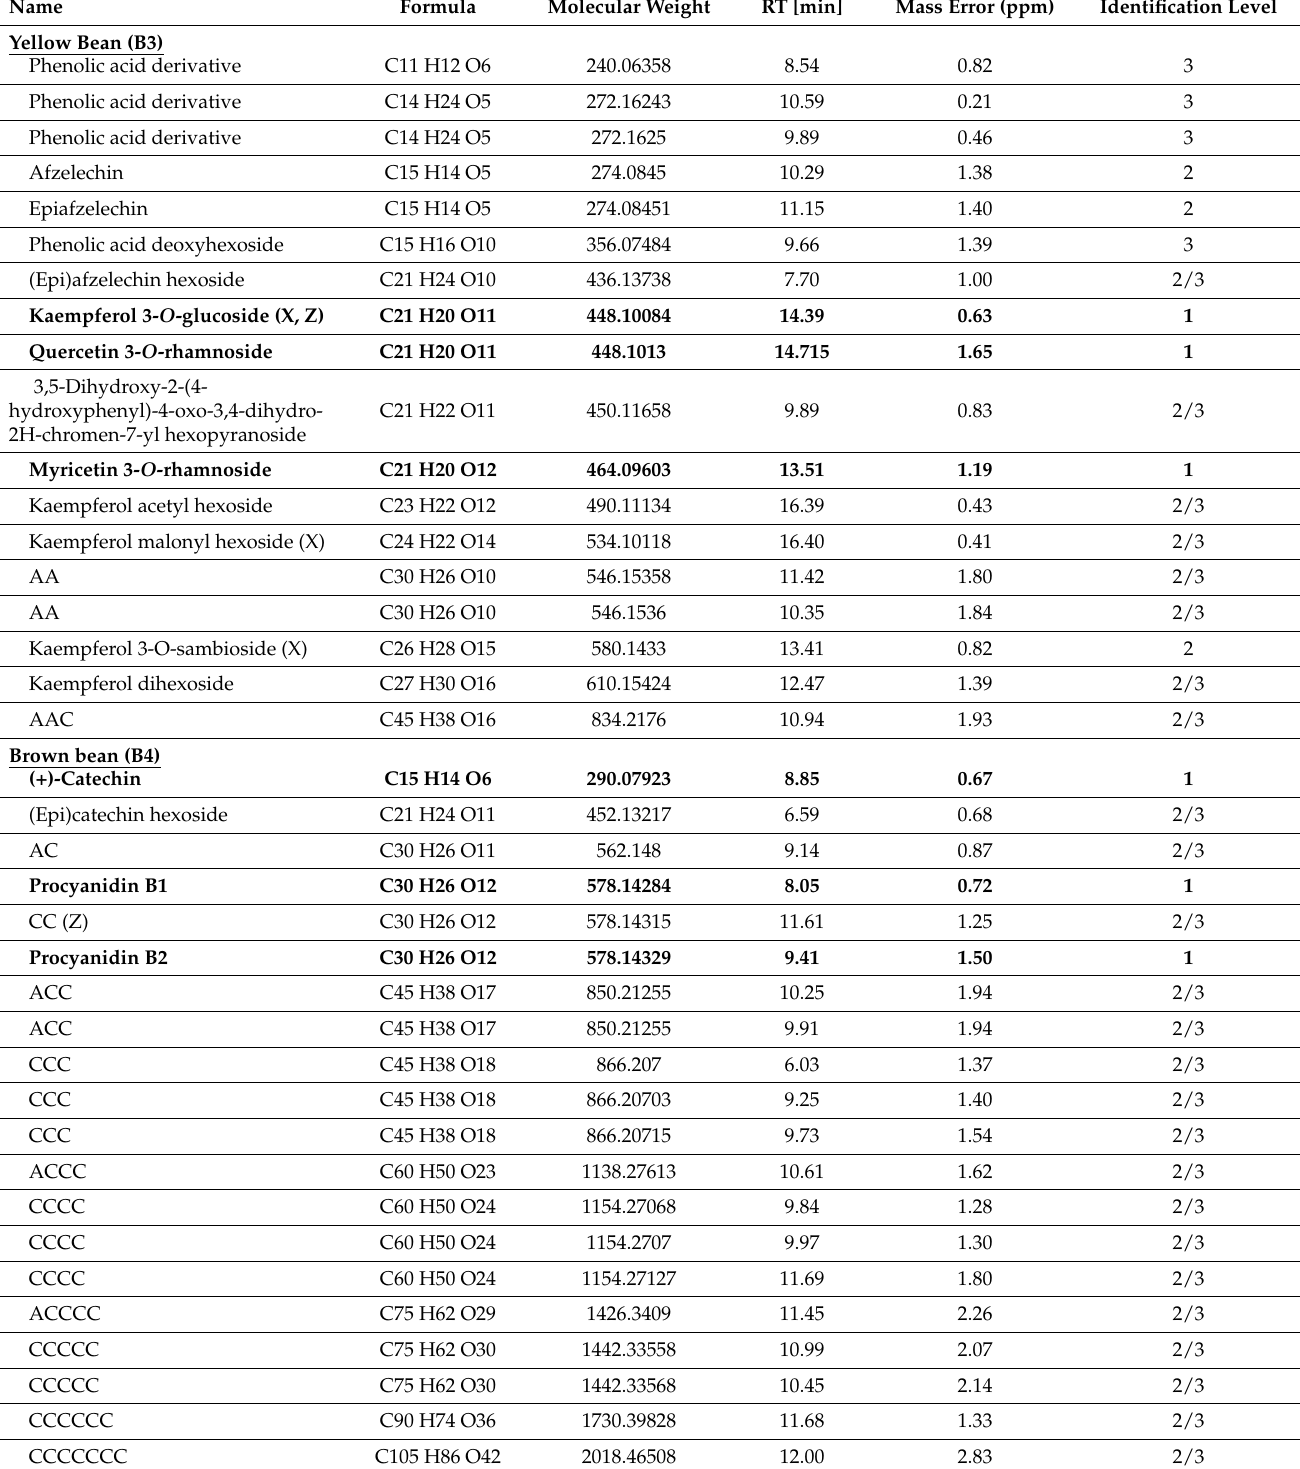
Table 2. Identification of the compounds used in the Hierarchal clustering plot (HCA). C: (epi)catechin, A: (epi)afzelechin and G: (epi)gallocatechin. (X) refers to the presence of an adduct, (Y) refers to the presence of a water adduct, and (Z) refers to the presence of a dimer. Identification levels are: confirmed (1), putative (2), isomeric (2/3), class only (3) and unidentified (4). Compounds in bold were (semi)quantified using the targeted method